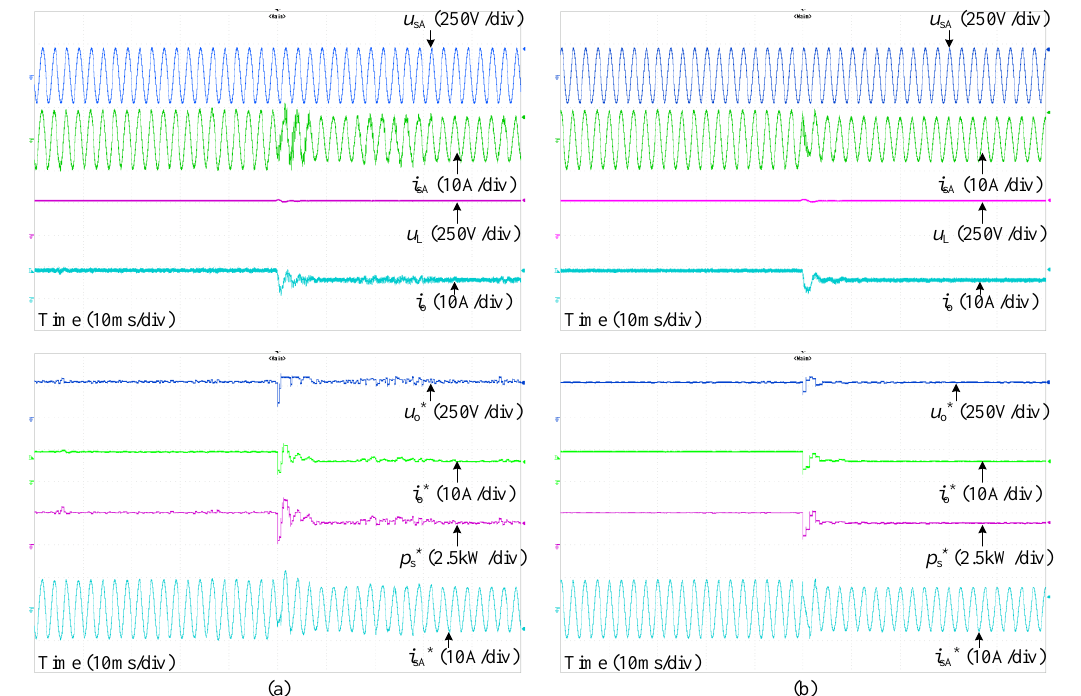
Figure 9. Dynamic response of the proposed scheme when the load resistor changes from 30 to 45: ( a ) the output sampling time T so was 333 s and ( b ) T so was 667 s.